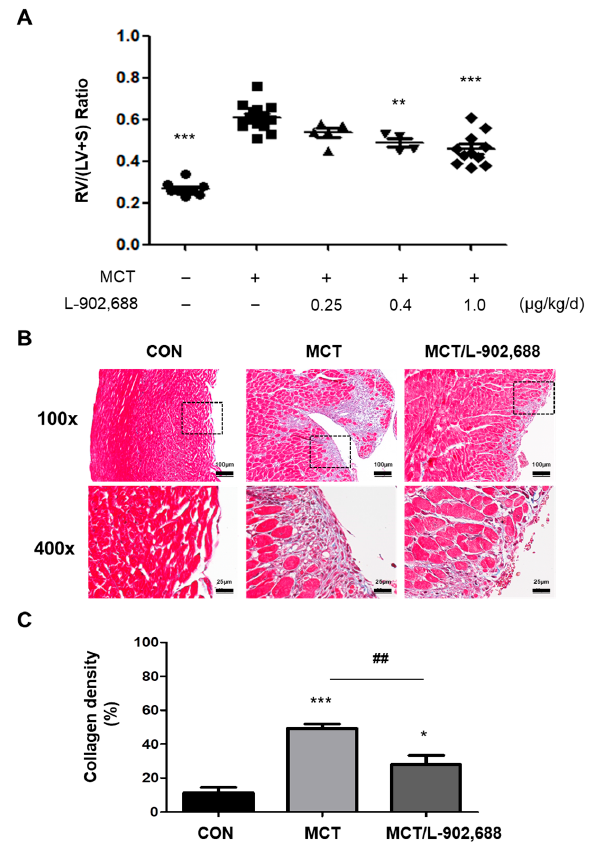
Figure 4. Histological analysis of trichrome-stained right ventricular (RV) tissue. ( A ) Administration of L-902,688 from the 8th to the 28th day after monocrotaline (MCT) injection decreased the RV/(LV + S) weight ratio in MCT-induced PAH rats. (CON n = 10, MCT n = 15, MCT/L-902,688 0.25 µ g/kg/day n = 5, MCT/L-902,688 0.4 µ g/kg/day n = 4, MCT/L-902,688 1.0 µ g/kg/day n = 11). ** p < 0.01 and *** p < 0.001 versus MCT group. ( B ) The histological analysis of trichrome-stained RV tissue demonstrated greater collagen (purple) deposition in the endocardium of MCT rats at week 4 than in that of control (CON) rats. EP4 agonist 1 µ g/kg/day (MCT/L-902,688) treatment significantly reduced collagen deposition. Scale bars = 100 and 25 µ m. ( C ) Quantitative analysis of collagen deposition by a color deconvolution method demonstrated a significant reduction in the percentage of fibrosis among the total tissue area. Bars represent the mean ± SE ( n = 5 per group); * p < 0.05 and *** p < 0.001 versus CON; ## p < 0.01 versus the MCT